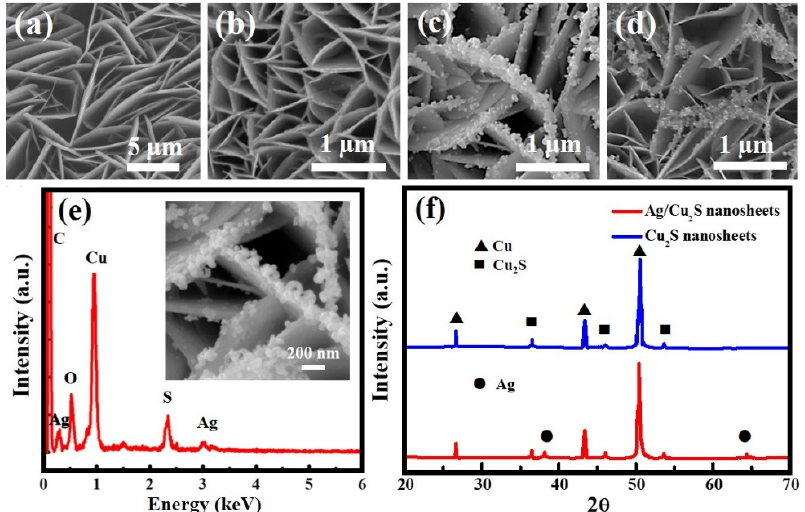
Figure 1. SEM images of ( a ) Cu S nanosheets and Ag/Cu S prepared at ( b ) 20 °C, ( c ) 30 °C, and ( d ) 2 2 ( d ) 40 ◦ C. ( e ) EDX analysis of Ag/Cu 2 S nanosheets prepared at 30 ◦ C. The inset SEM image reveals 100 nm Ag NPs were well deposited on the edge of 30 ◦ C immersed Ag/Cu 2 S nanosheets. ( f )